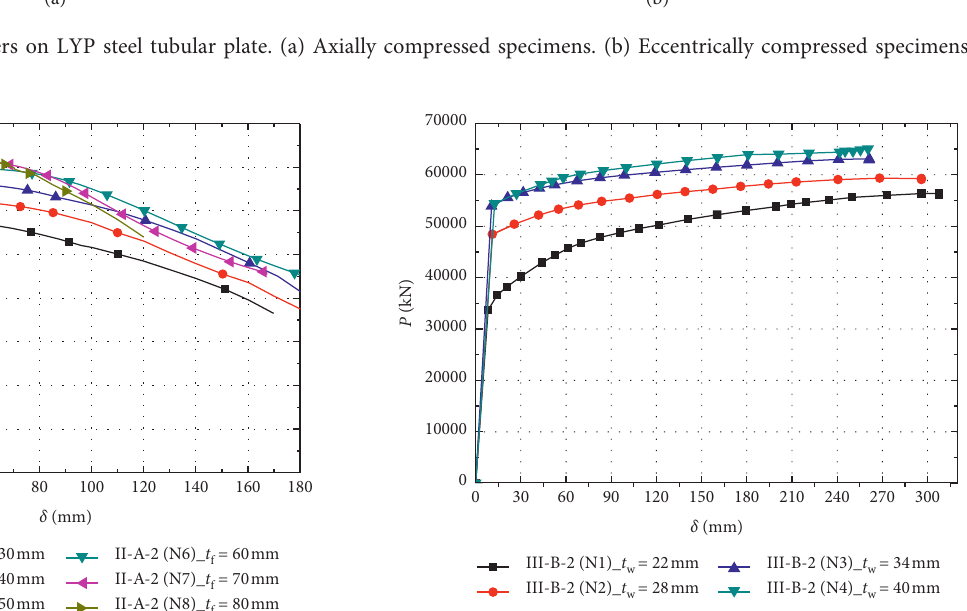
Figure 18: Effects of thickness of outer constrained steel plate on skeleton